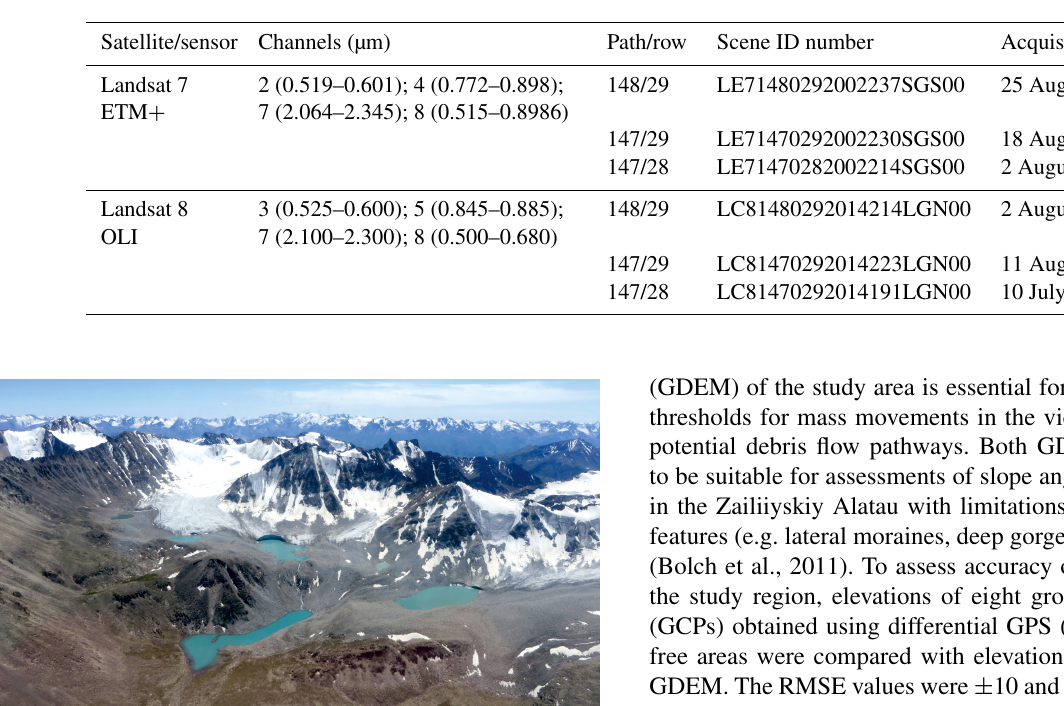
Table 1. Characteristics of the Landsat images used in this study. The July 2014 scene covered an area containing 15 lakes (2% of all lakes as in 2014).